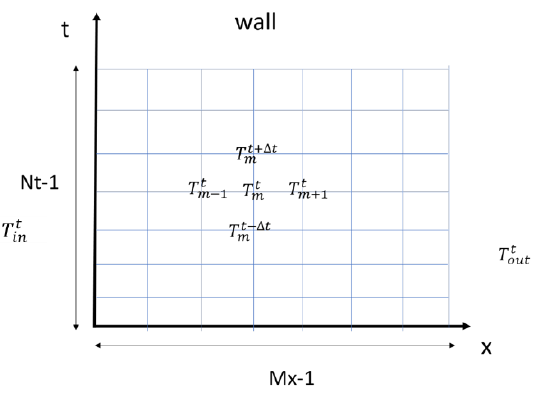
Figure 2. Working procedure of the explicit FE method, where T in and T out are the air temperatures at the internal and external sides of the wall.